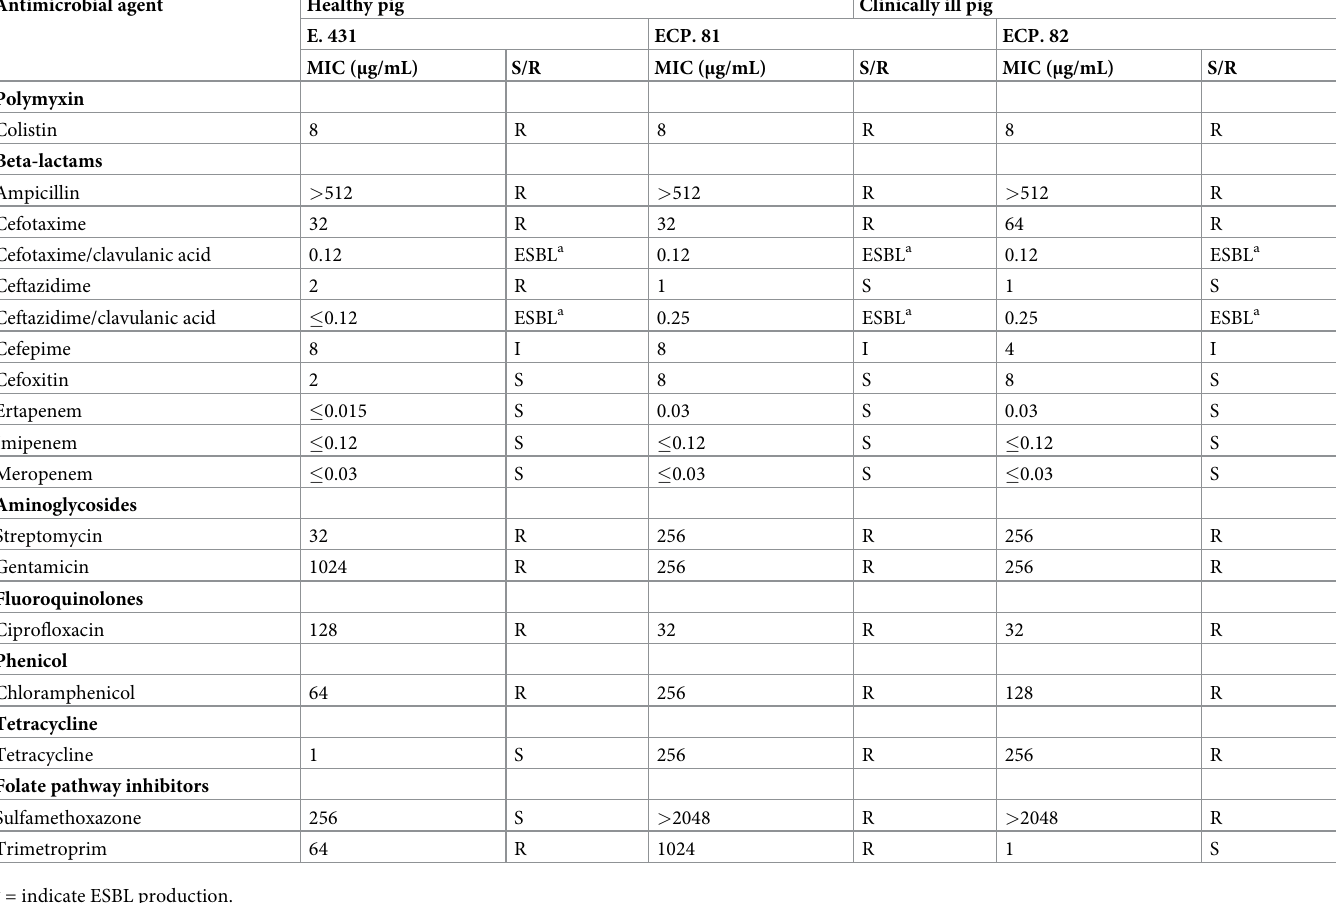
Table 1. Antimicrobial susceptibilities of ESBL-producing E . coli carrying mcr from pigs in Thailand (n = 3). Antimicrobial agent Healthy